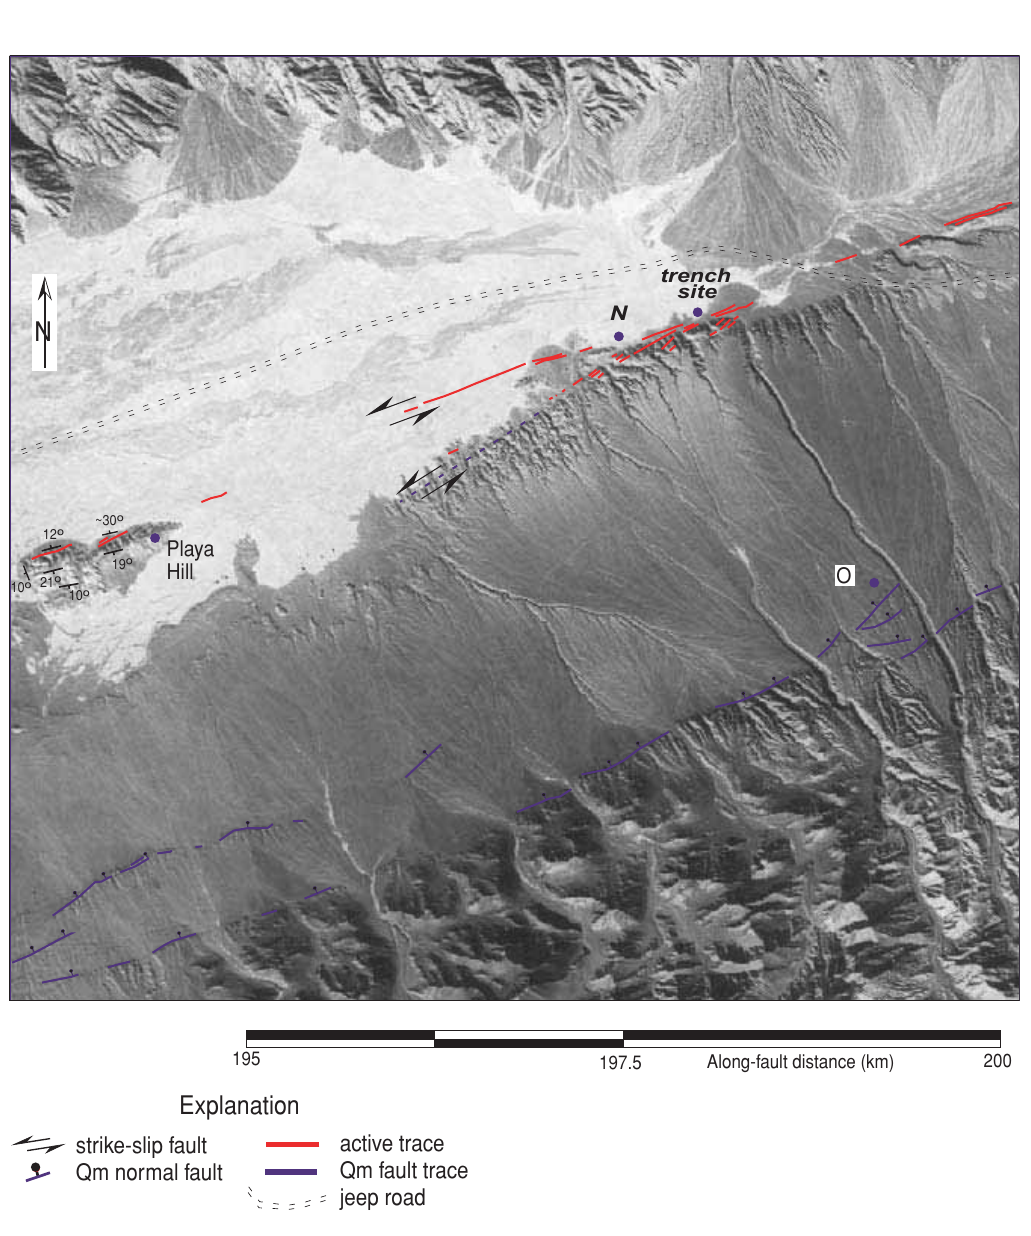
Fig. 4. Fault trace map showing main strike-slip rupture cutting Playa Hill, the eastern end of the playa, small alluvial fans at the base of north facing escarpment, and the Camel paleoseismic site. Note the 058°-striking secondary strike- slip fault, which intersects the main trace at (N) and dies out within (cid:190) 2 km along strike to the southwest. The Qm nor- mal faults located along the piedmont and range front to the south have 1-8 m high degraded scarps indicating they have not ruptured recently. The only exception is a slightly sharper scarp seen at (O). However its more distal position may explain this morphologic difference. Base image is a rectified CORONA photograph. See fig. 3 for location of this